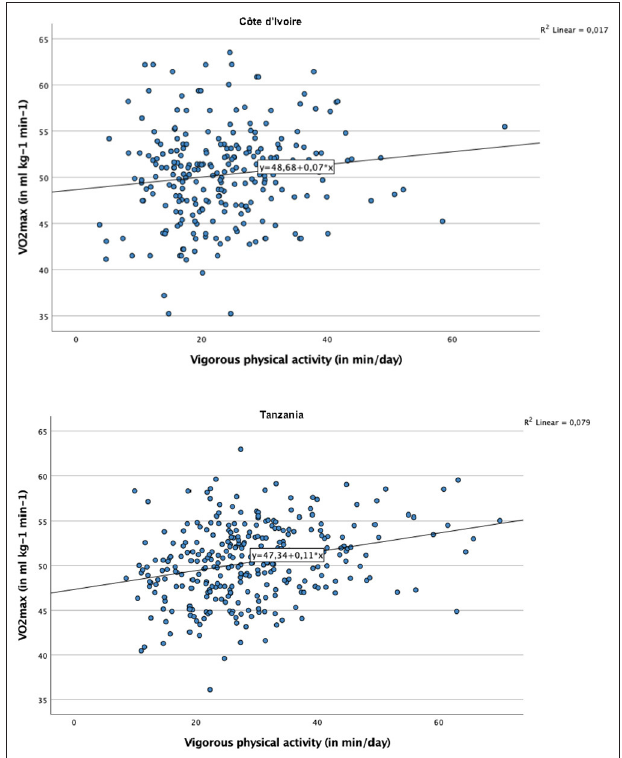
FIGURE 2 | Scatter plot with regression line representing the association between vigorous physical activity and cardiorespiratory fitness, for girls from Côte d’Ivoire and Tanzania.